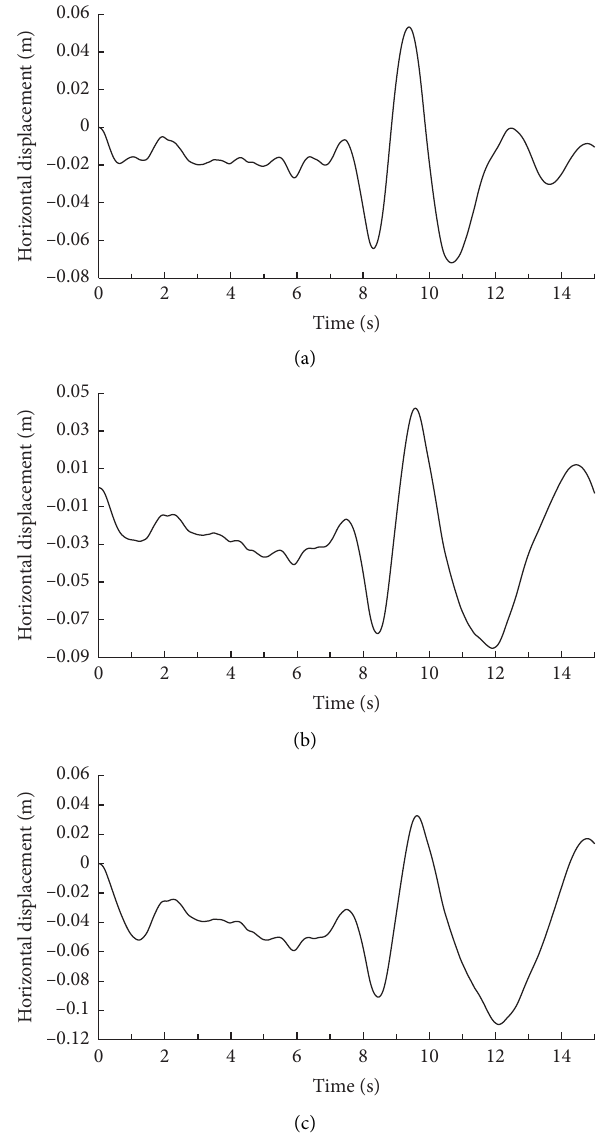
Figure 7: Horizontal displacement-time history curves for (a) the 30m layer at node 398, (b) the 60 m layer at node 261, and (c) the 80m layer at node